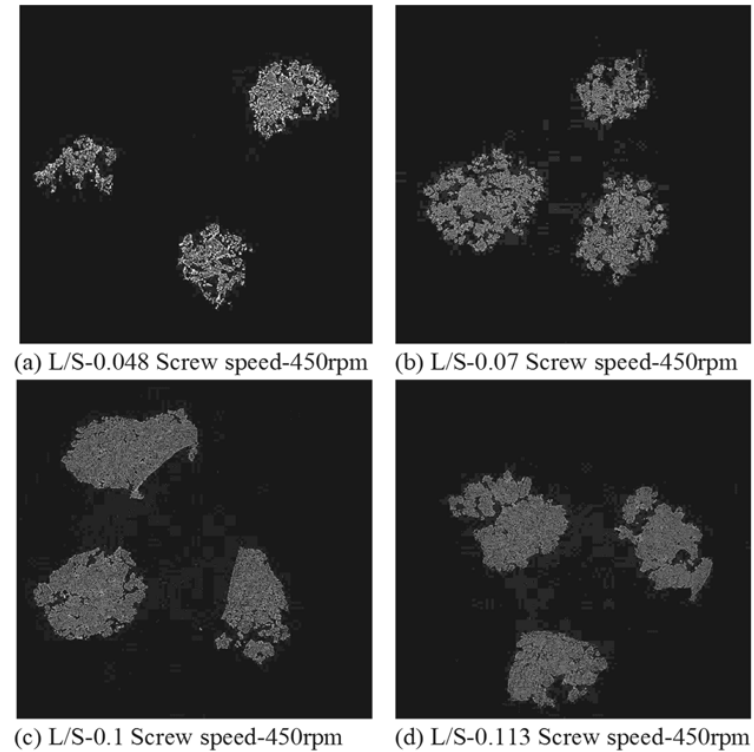
Figure 9. X ‐ ray tomographic images of granules produced using SuperTab21AN at varying L/S (screw speed, 450 rpm).